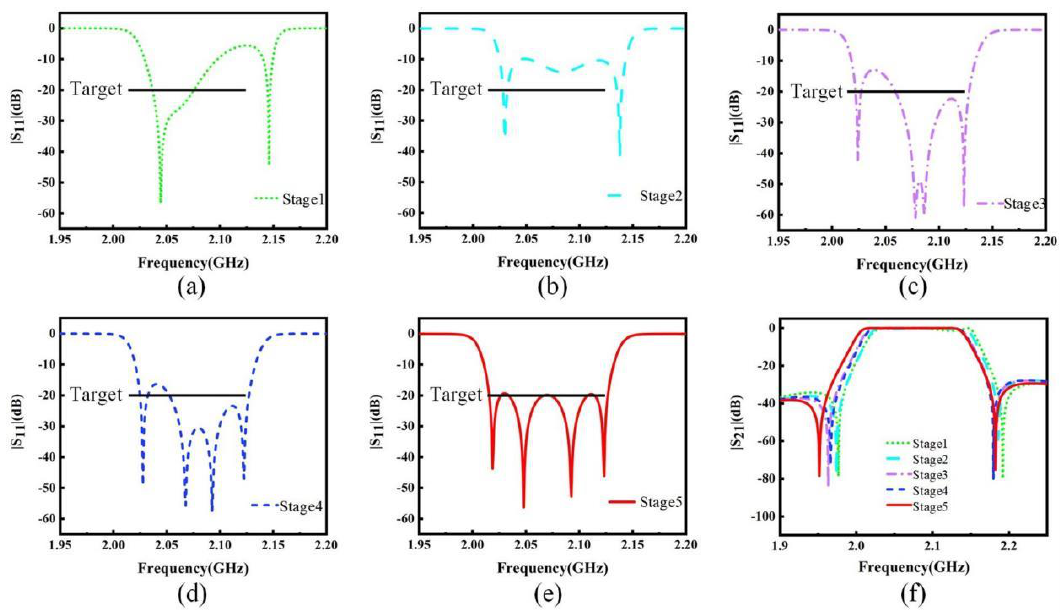
Figure 9. Fourth−order cavity filter HFSS verification of the optimized response in PSO iterations. ( a – e ) Reflection coefficient S 11 . ( f ) Transmission coefficient S 21